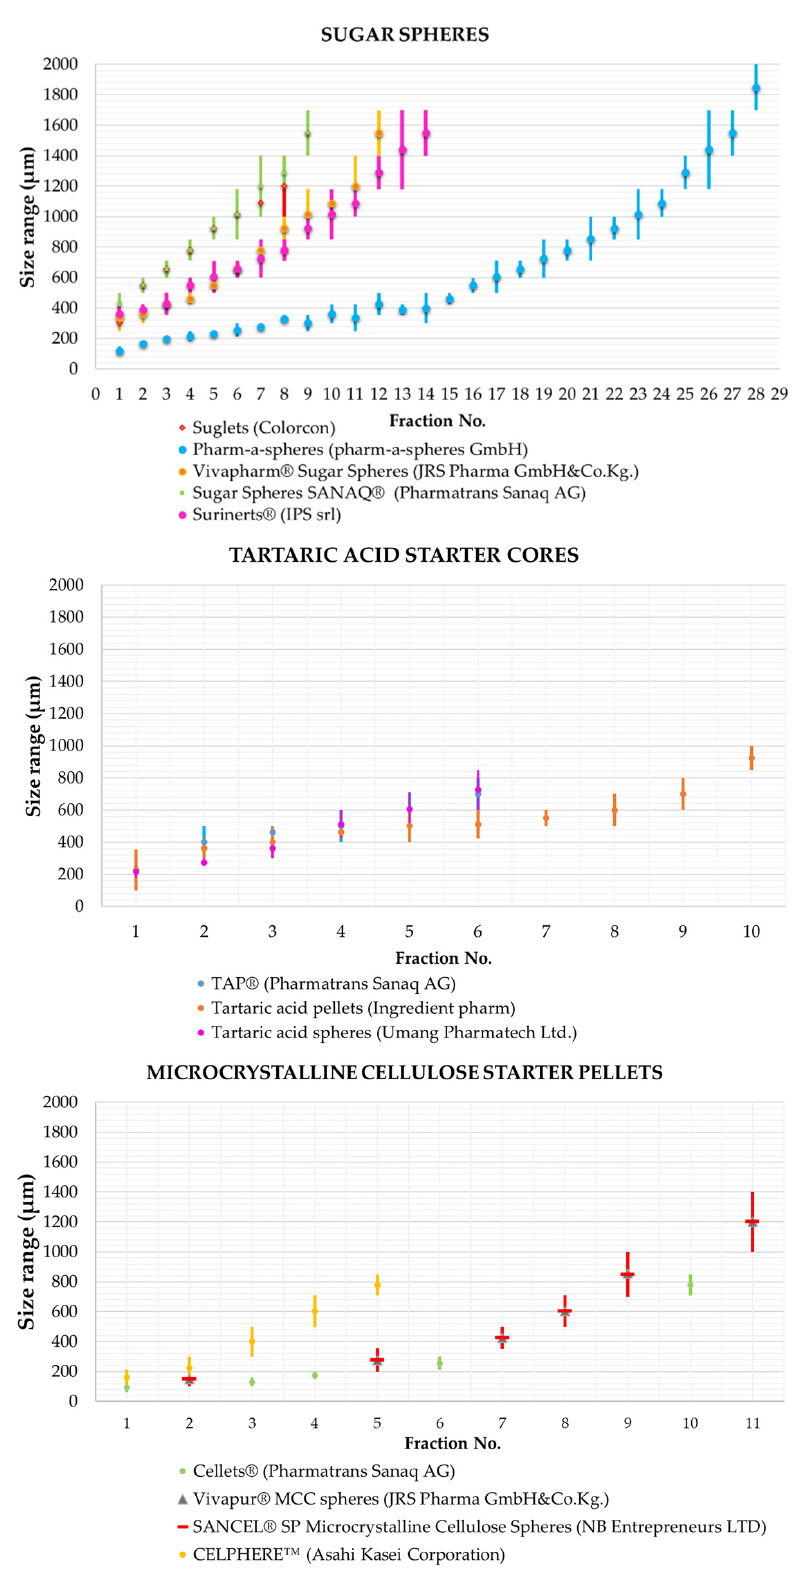
Figure 5. Examples of pellet size ranges available on the market: sugar spheres [69–73], tartaric acid starter cores [74–76], and microcrystalline cellulose starter pellets [77–80]. Pellet shape: Shape is a critical quality factor, as a rounded/spherical shape is preferred. Figure 6 shows scanning electron micrographs of various inert pellet cores showing that the investigated, marketed particles are nearly spherical.